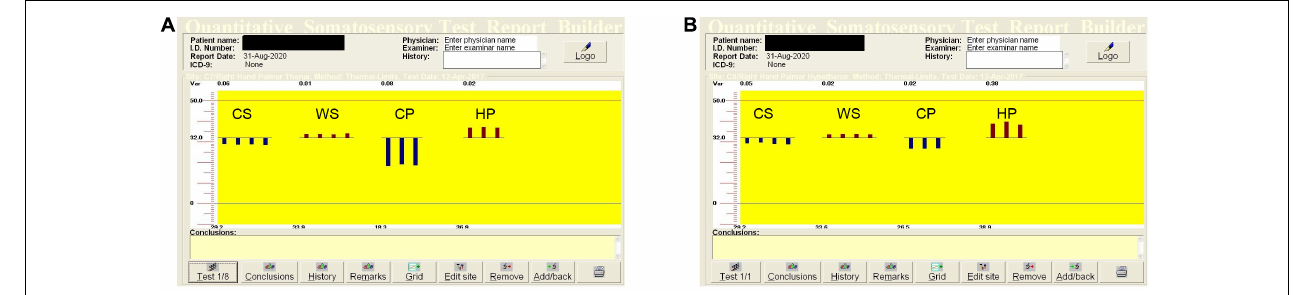
FIGURE 1 | Quantitative sensory testing (QST) in the median (A) and ulnar (B) nerves in the right hand in a healthy, 51-years old woman. The dispersions of the temperatures are: for low temperatures (CP–CS) in the median nerve–10.9 ◦ C, in the ulnar nerve–2.7 ◦ C, for high temperatures (HP–WS) in the median nerve–3.0 ◦ C, in the ulnar nerve–5.3 ◦ C. QST, quantitative sensation testing; CS, cold sensation; WS, warm sensation; CP, cold pain; HP, heat pain.